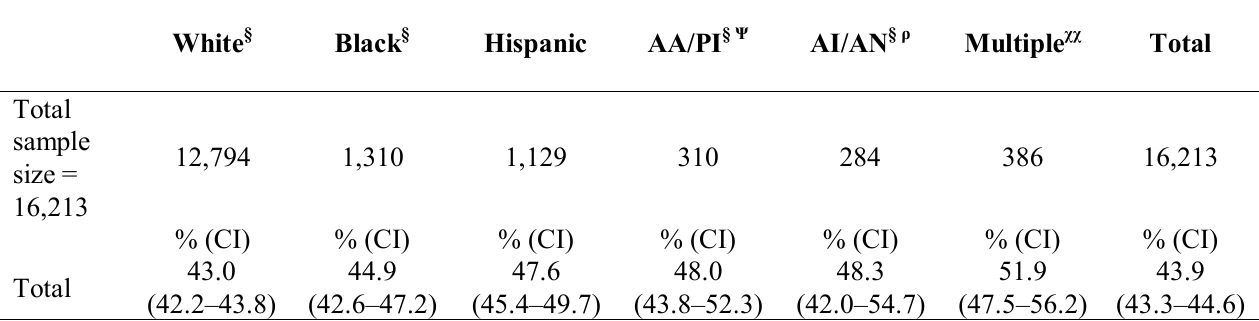
Table 1. Proportion of smokers Ф who reported a quit attempt in the past year by race/ethnicity and other demographic